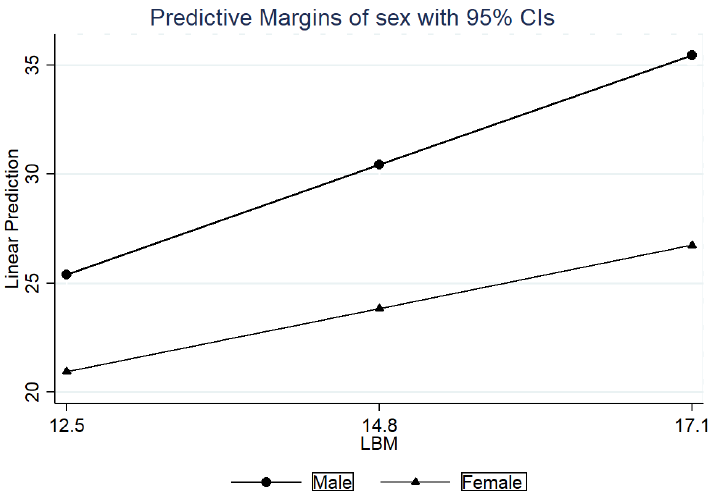
Figure 3. Probabilities predicted by sex compared to lean body mass with grip strength in adolescents. São Luís, Maranhão, Brazil, 2016/2017.